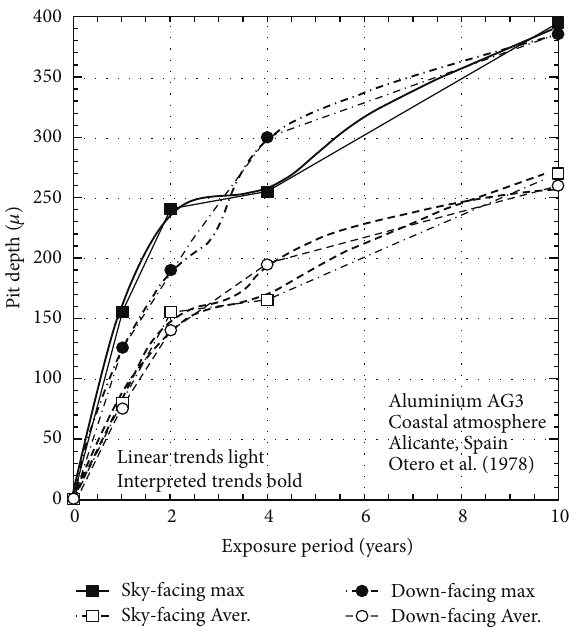
Figure 5: Data for maximum pit depth of aluminium alloy AG3 exposed in a coastal atmospheric environment at Alicante, Spain. The trends for pit depth are clearly bimodal or can be interpreted easily as such. The downward facing coupons show more aggressive pitting. In this case the changeover to mode 2 occurs at about 3-4 years of exposure. Data from Otero et al. [15].